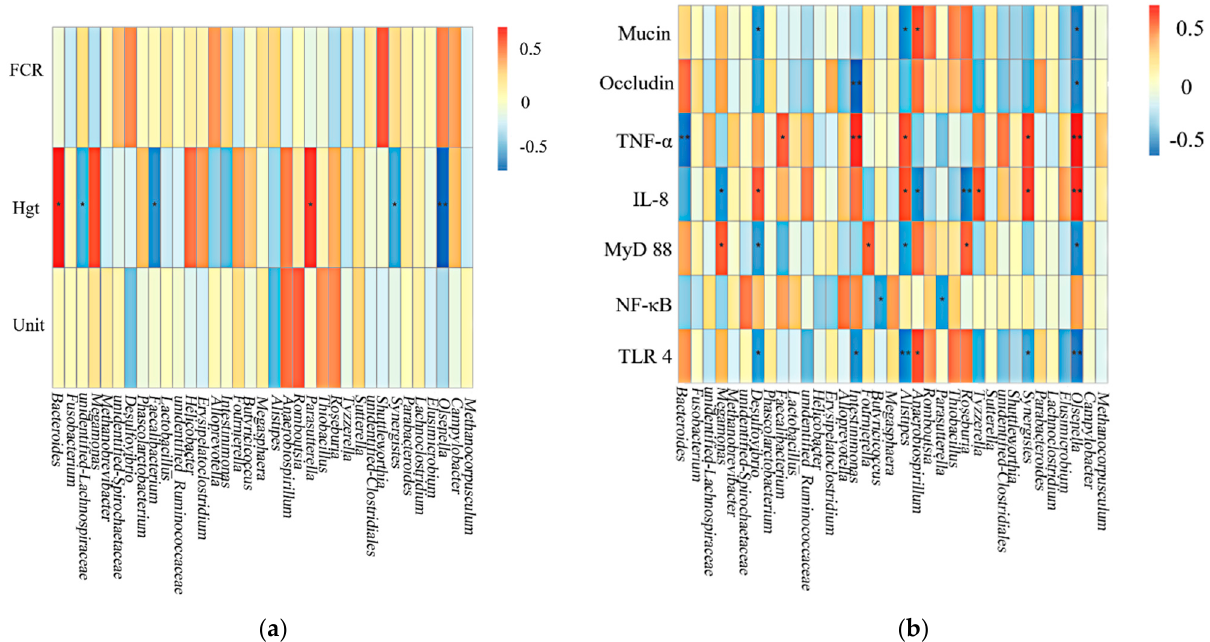
Figure 3. Correlation of laying performance 1 , gut-associated gene expression 2 , and gut bacteria. * p < 0.05, ** p < 0.01. Red represents a positive correlation, and blue represents a negative correlation. ( a ) Effects on laying performance. FCR, feed conversion ratio; Hgt, Albumen height; Unit, Haugh unit. ( b ) Effects on gut-associated gene. 2 Mucin, Mucin-2; TNF- α , Tumor necrosis factor – α ; IL-8, Inflammatory mediators interleukin-8; MyD88, Myeloid differentiation primary response; TLR-4, Toll-like receptor 4.